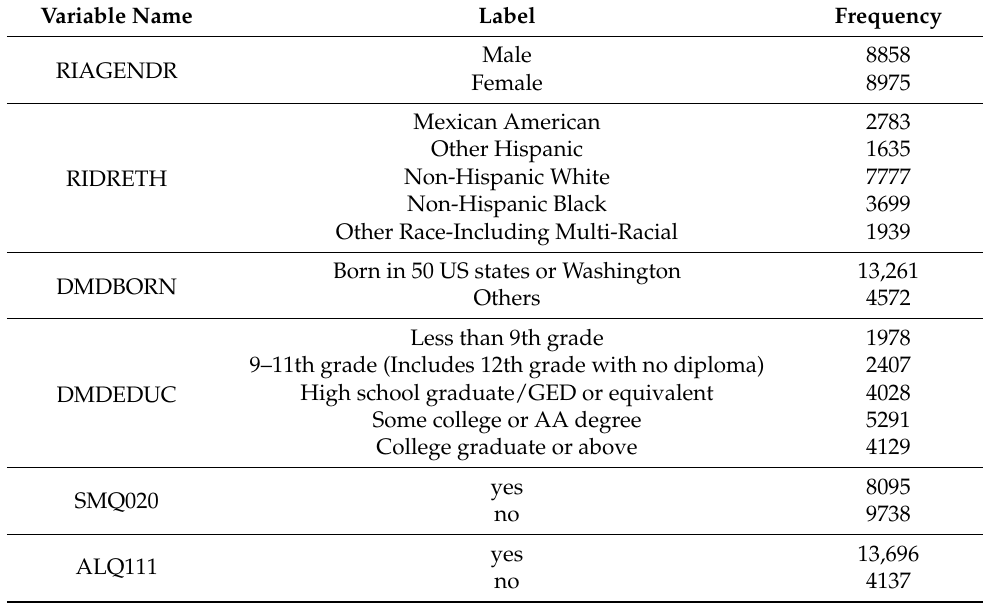
Table 4. Descriptive Analysis of Categorical